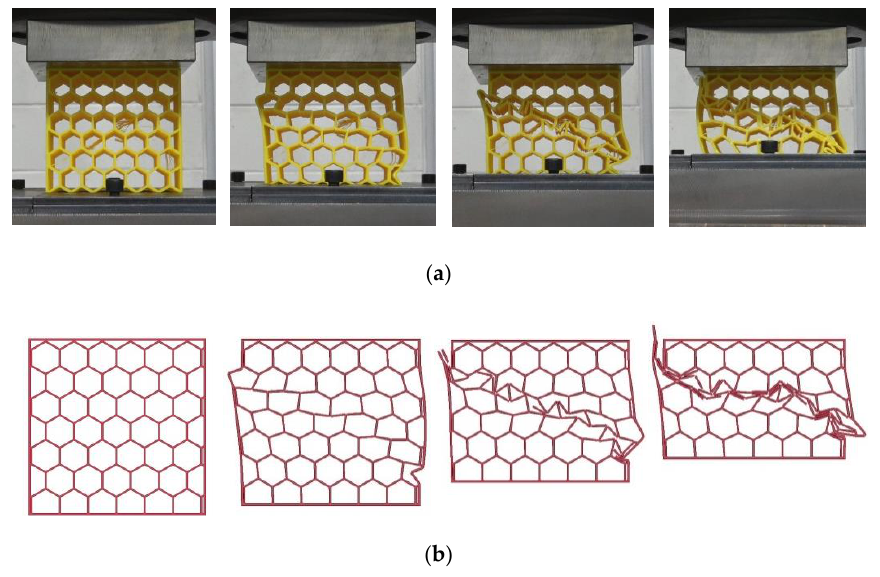
Figure 4. Comparisons of Honeycomb Compression Experiment and Simulation: ( a ) Experimental results of a Honeycomb specimen; ( b ) Simulation results of a Honeycomb specimen.